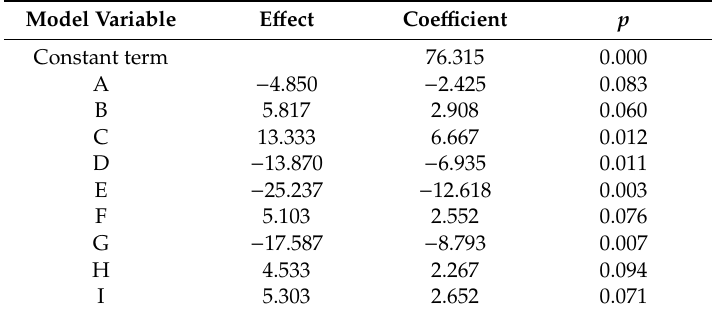
Table 5. Significance analysis of Plackett-Burman experiment design parameters.